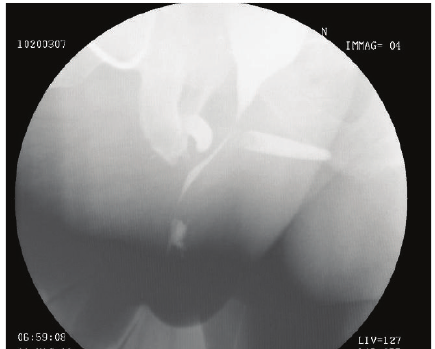
Figure 2: Voiding cystourethrogram showing radiocontrast leak.